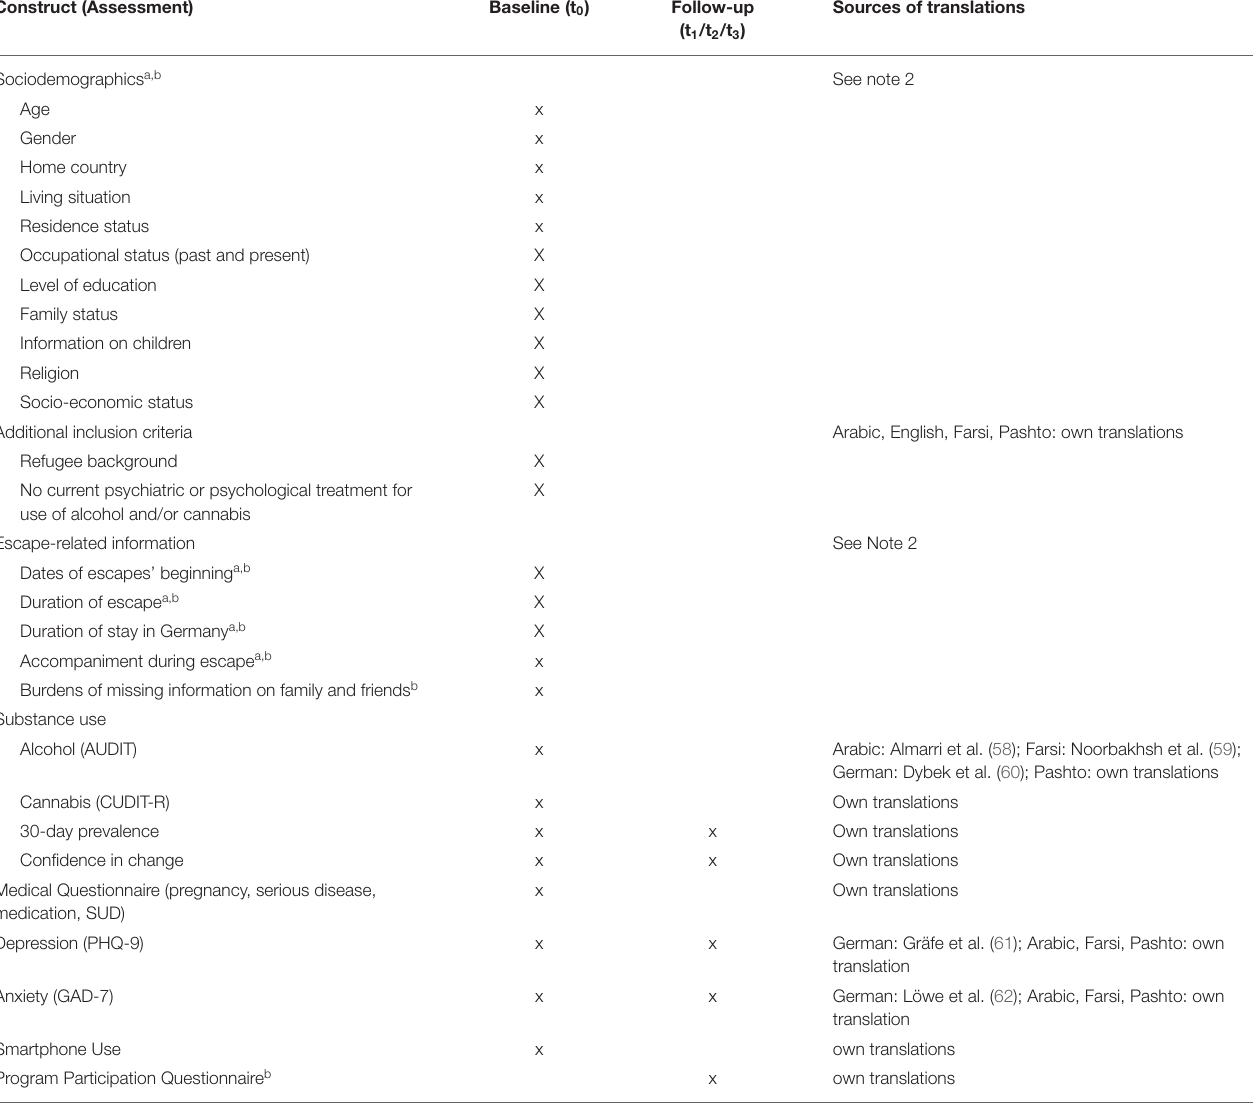
TABLE 2 | Measures and assessment at points used in the